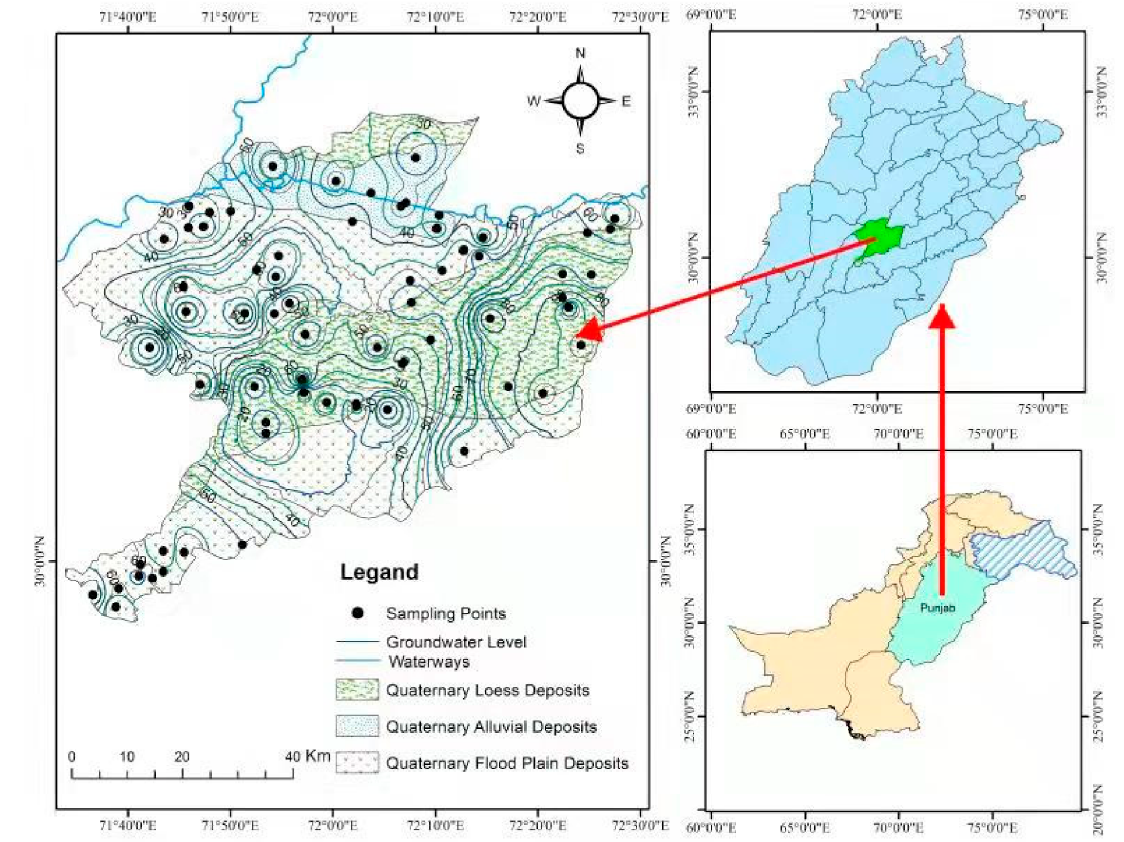
Figure 1. Groundwater sampling points and geological formation of Khanewal